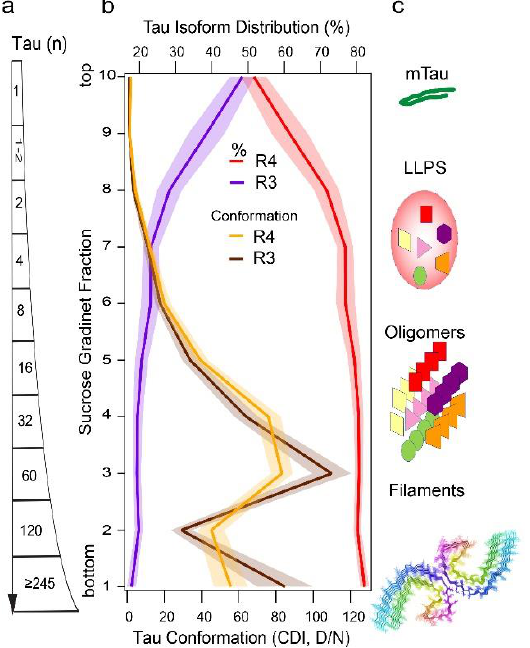
Figure 2. Size, 3R and 4R isoform distribution, and conformation of tau particles in the hippocampus of AD cases. ( a , b ) Size, concentration, and conformation of insoluble misfolded 4R and 3R tau fractionated by sedimentation velocity using ultracentrifugation in sucrose gradient were analyzed simultaneously by 4R- and 3R-specific CDI. ( c ) The schematic representation of normal tau monomer and different structural forms of misfolded tau proteins-induced ensembles of dynamic liquid-liquid phase separation (LLPS) [146], oligomers [147], and PHF structures [105]. The composite sucrose gradient is replotted from recently published data [10] and the structure of PHF was generated by Cn3D application from published coordinates [105].